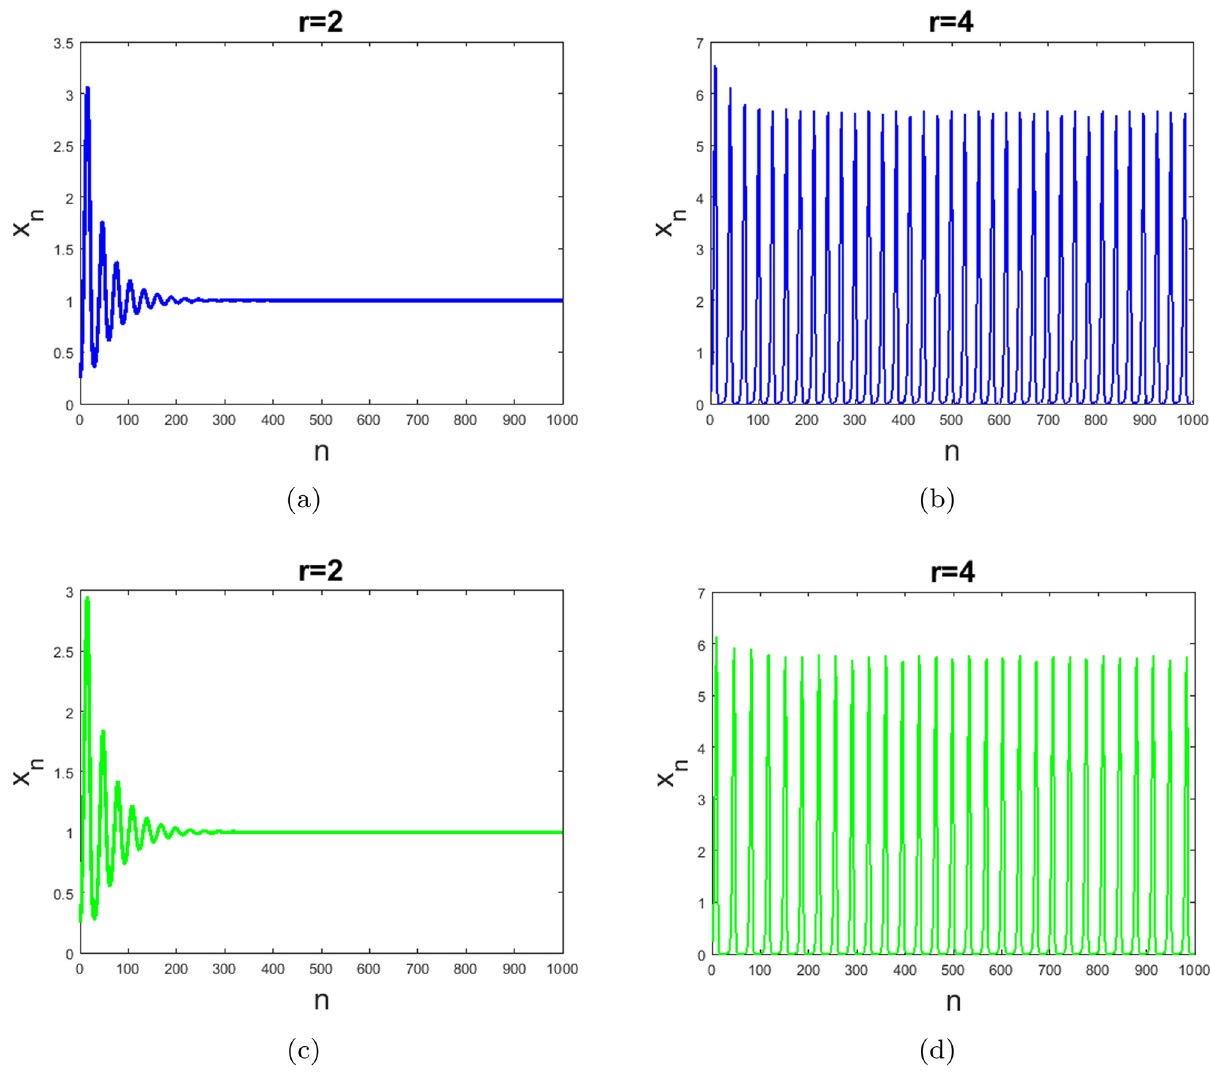
Figure 9: Time series plot of system ( 8 ) with respect to Figure 5 ( a ) : ( a ) asymptotically stable for = r 2 and ( b ) chaotic for = r 4 , and system ( 22 ) with respect to Figure 6 ( a ) : ( c ) asymptotically stable for = r 2 and ( d ) chaotic for = r 4